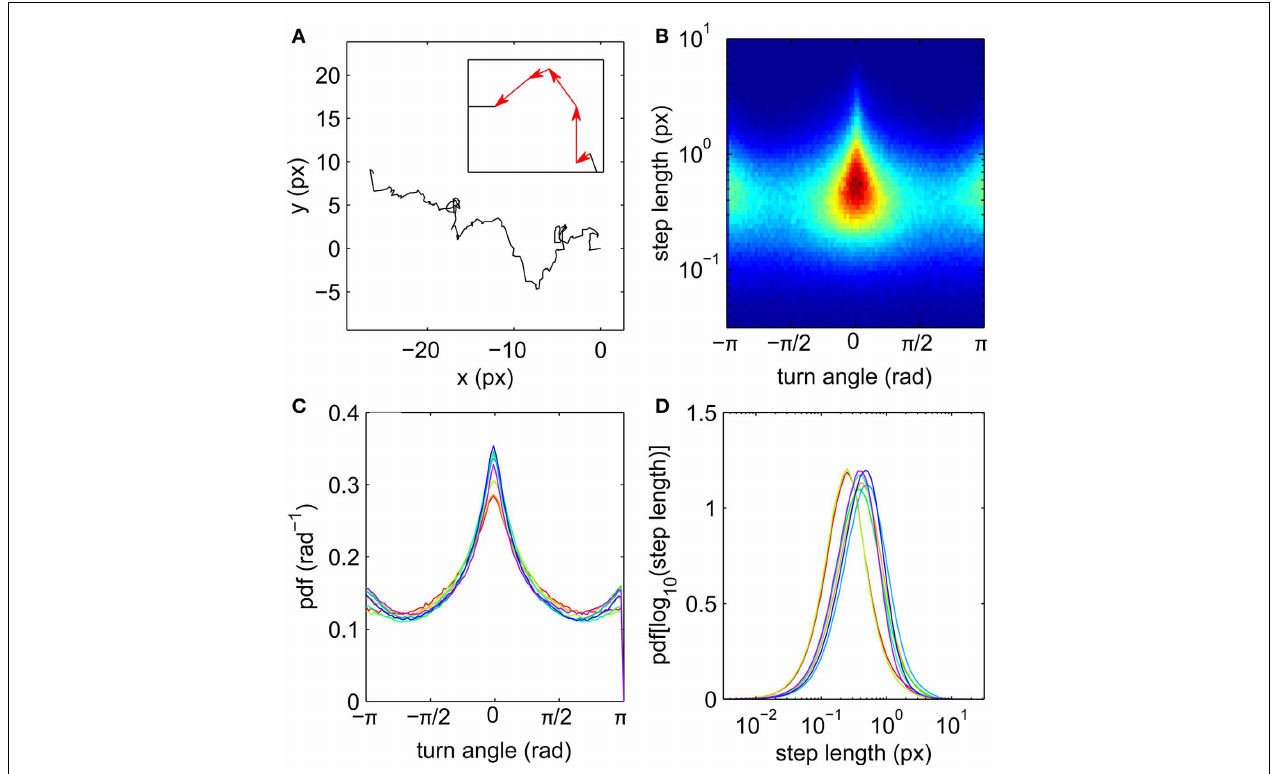
FIGURE 1 | Fixational eye movements and distributions of steps. (A) Example fixation gaze trajectory, with inset showing four steps as vectors joining gaze points. (B) Joint step length and turn angle distribution for one